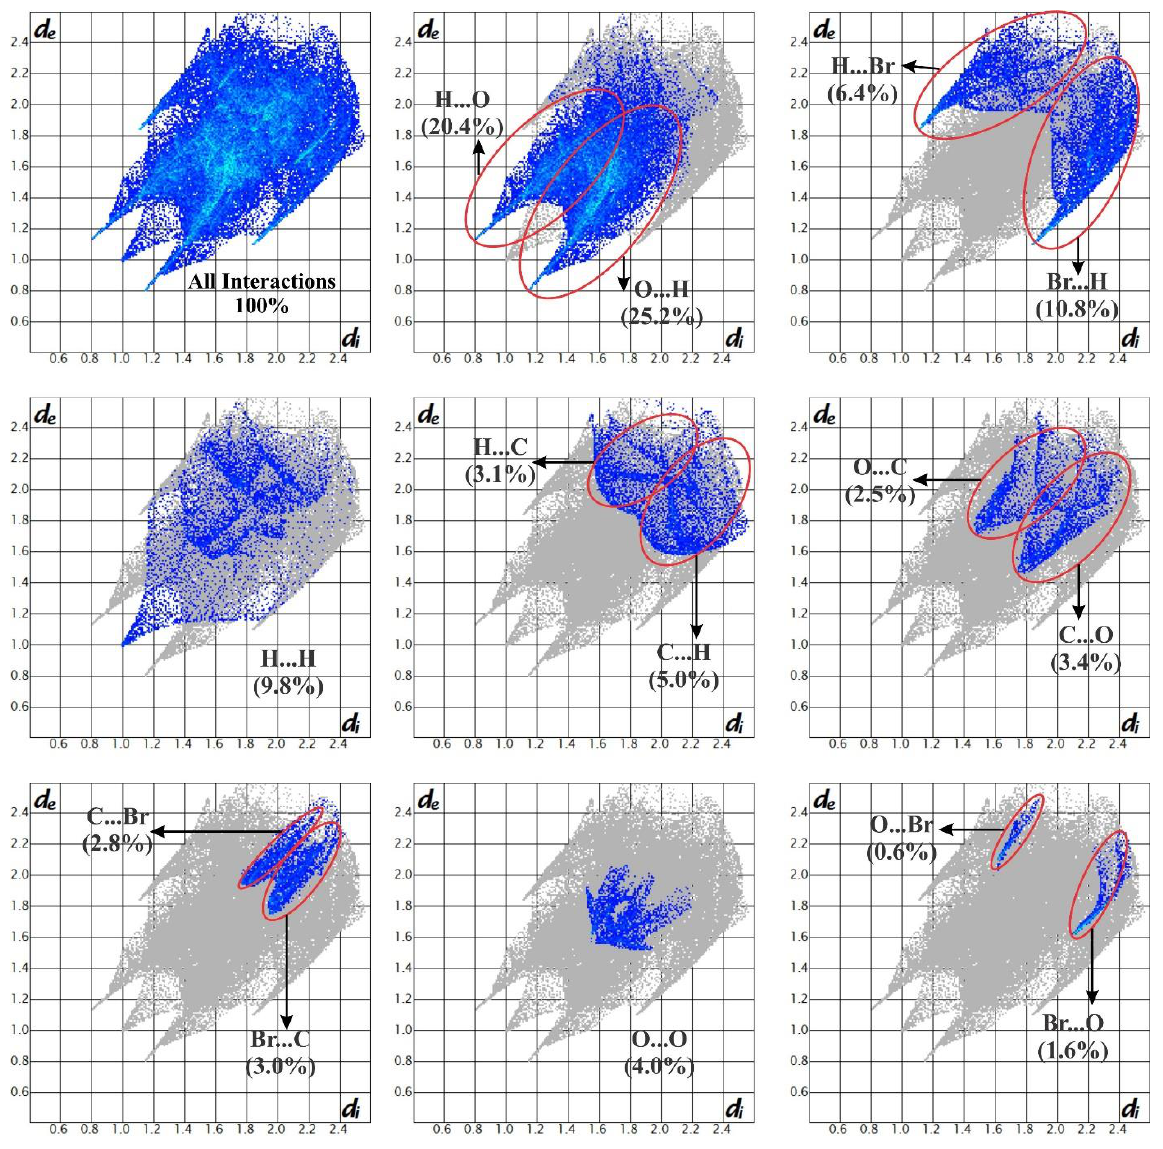
Figure 6. Fingerprint plots of 4BAP.